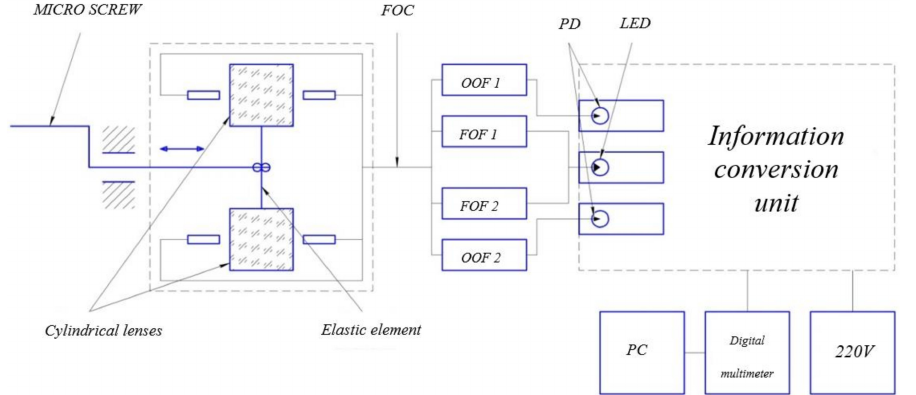
Figure 6. Installation for setting micromovements with ICU. PD—photodiode; SD—LED; PC—personal computer; FOC—fiber optic cable.